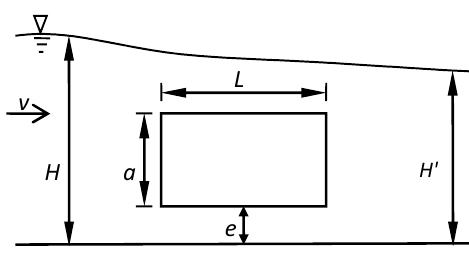
Figure 2. Schemes of the hydrodynamics parameters. Table 1. Experimental